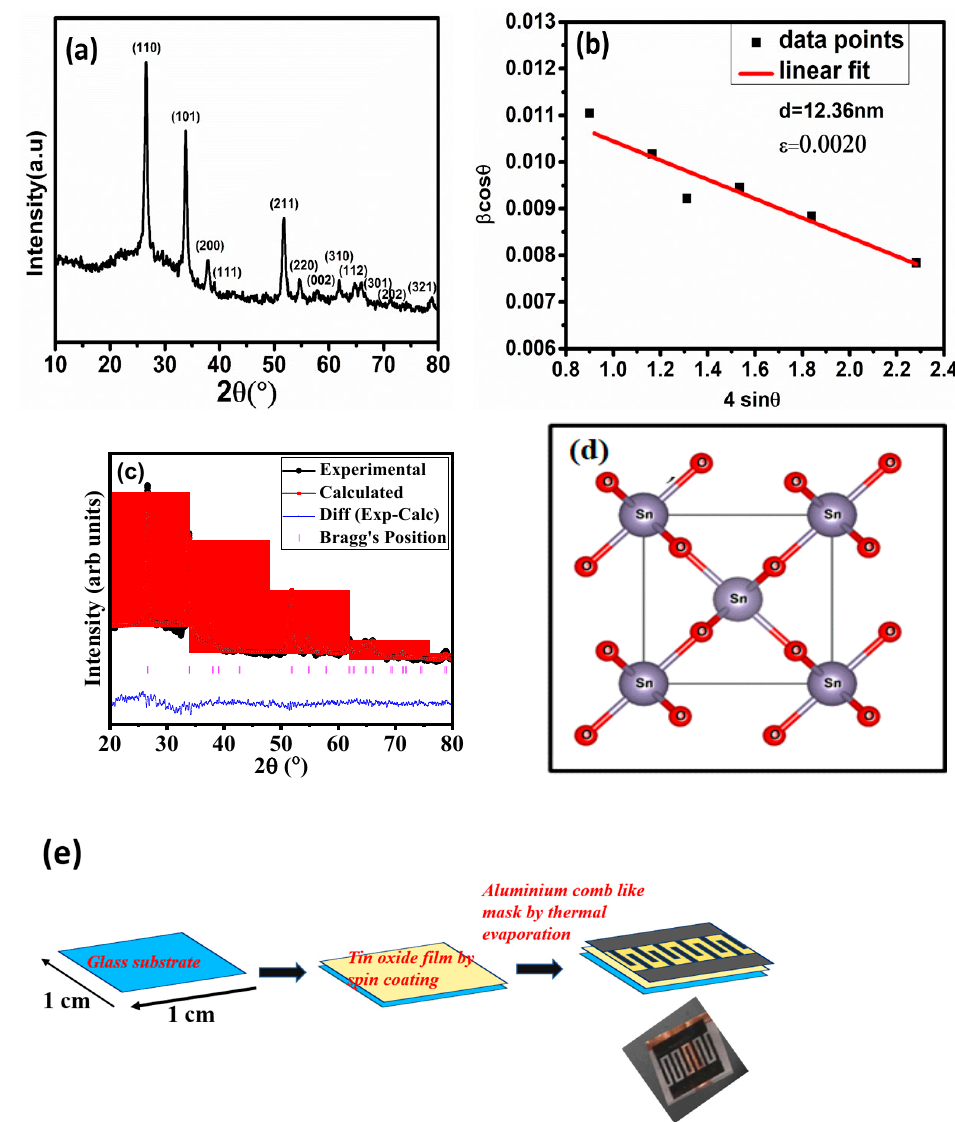
Figure 1. ( a ) XRD patterns of SnO 2 nano-powder with indexed diffraction peaks corresponding to standard JCPDS data card (41-1445). ( b ) W-H plot of the synthesised material. ( c ) Refinement of SnO 2 compared with the standard Bragg position. ( d ) Schematic diagram of a unit cell of SnO 2 originated using Vesta software. ( e ) Schematic diagram of the fabrication of the device.